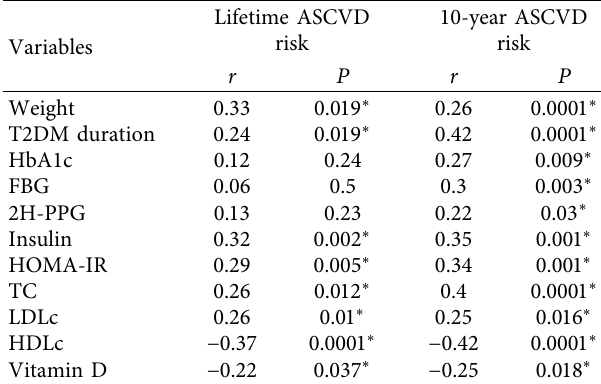
Table 4: Correlation of lifetime and 10-year ASCVD risk with variables among T2DM.